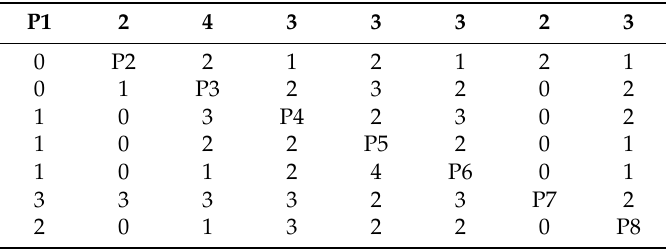
Table 3. Interaction matrix.